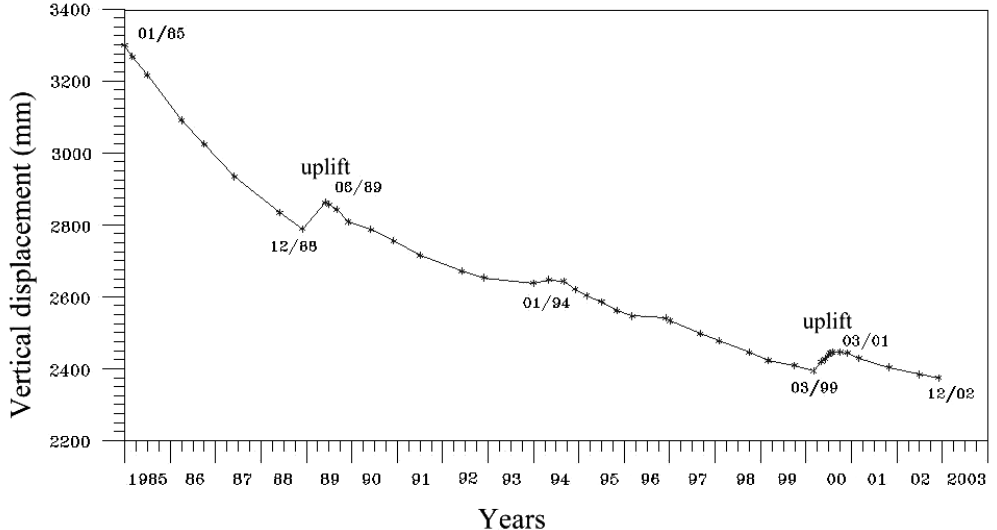
Fig. 2. Vertical displacement of benchmark n. 25 (located in the town of Pozzuoli) over the period 1985-2002